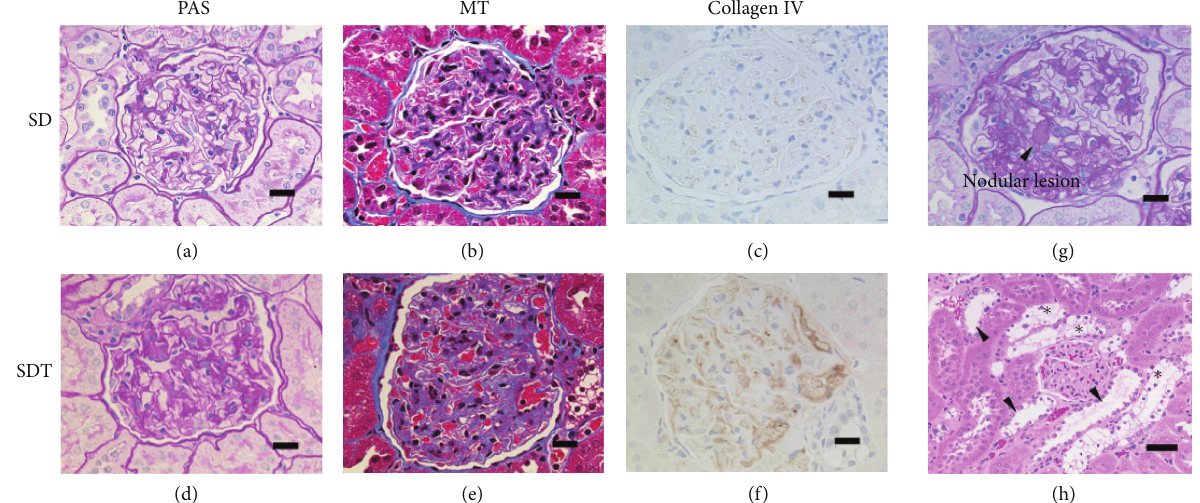
F 6: Histopathological observations in kidney of SDT rats. Histological and immunohistological analysis of glomeruli in SD rats (a–c) and SDT rats (d–f). In the glomeruli of SDT rats, basement membrane thickening and mesangial matrix proliferation were observed at 50 weeks of age (bar 20 m). Nodular lesions were found in a few glomeruli from 68-week-old SDT rats (g) (PAS stain, bar renal tubules of SDT rats, dilation (arrowhead) and glycogen deposition in the epithelium ( Figures are modi�ed from [41]. = 𝜇𝜇